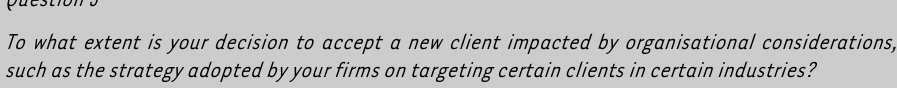
TABLE 5: Research results for question 3 Question